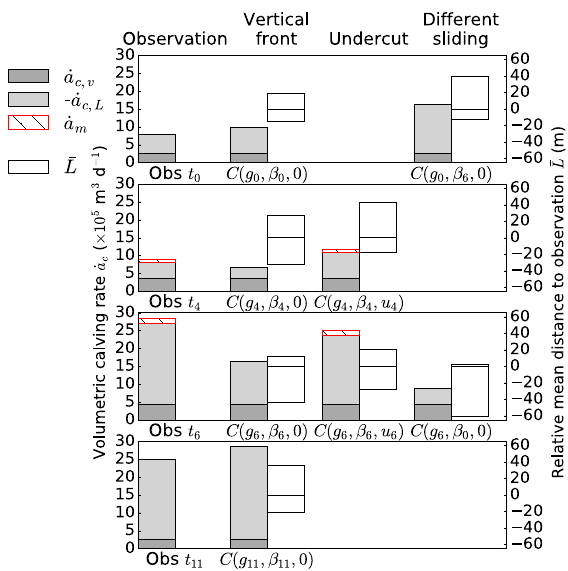
Figure 9. Observed and modelled mean volumetric calving rates, ˙ a c , in m 3 d − 1 , are presented as the integrated tangential (ice flow direction) ice front velocity ˙ a c ,v (dark grey), the integrated rate of change of the frontal position, ˙ a c ,L (light grey), and the total sub- aqueous melt rate, ˙ a m (red), if an undercutting is prescribed for each configuration. The mean distance differences between the modelled and the observed front positions, L , are shown on the right. A nega- tive value corresponds to underprediction of calving position (mod- elled in front of